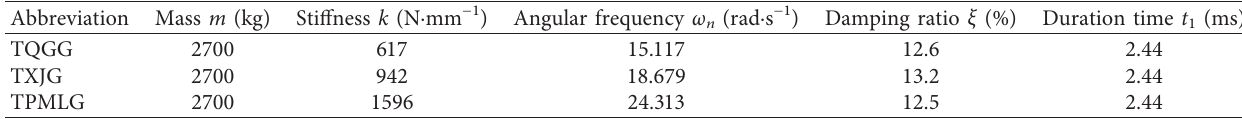
Table 4: Primary performance parameters of combined isolation devices.